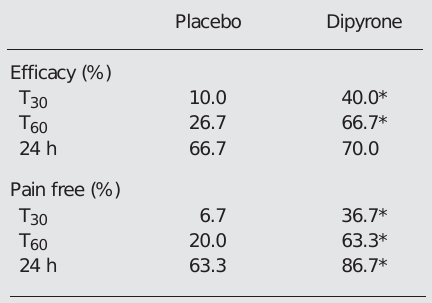
Table 1. Comparison of the efficacy of the drug (parameter 2) and pain-free status (parameter 3) in patients randomly assigned to receive placebo or